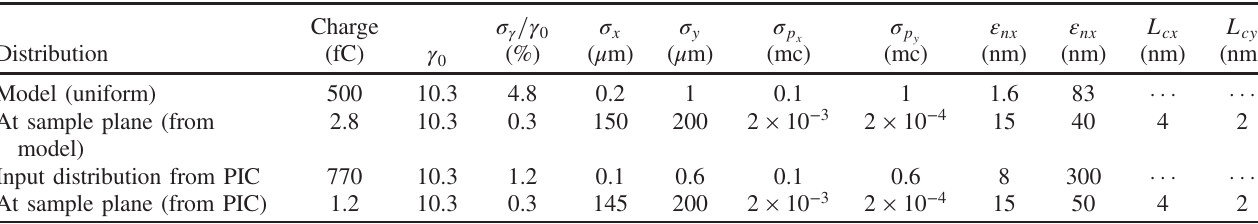
TABLE I. Parameters of the various distributions used in this work. Row 1: A distribution that models the PIC distribution shown in Fig. 2. The distribution is uniform; thus, the σ values correspond to the width of uniform distributions. Row 2: Parameters of the output distribution through the beam line when the model distribution is used (as in Figs. 5 and 6). Row 3: Parameters of the distribution from the PIC simulations shown in Fig. 2. Note that the energy spread was trimmed to 2% at FWHM for making computing in the particle-tracking simulations easier. Row 4: The resulting distribution at the sample plane obtained when the PIC distribution is used. For rows 2 – 4, the various σ represent the rms values of the